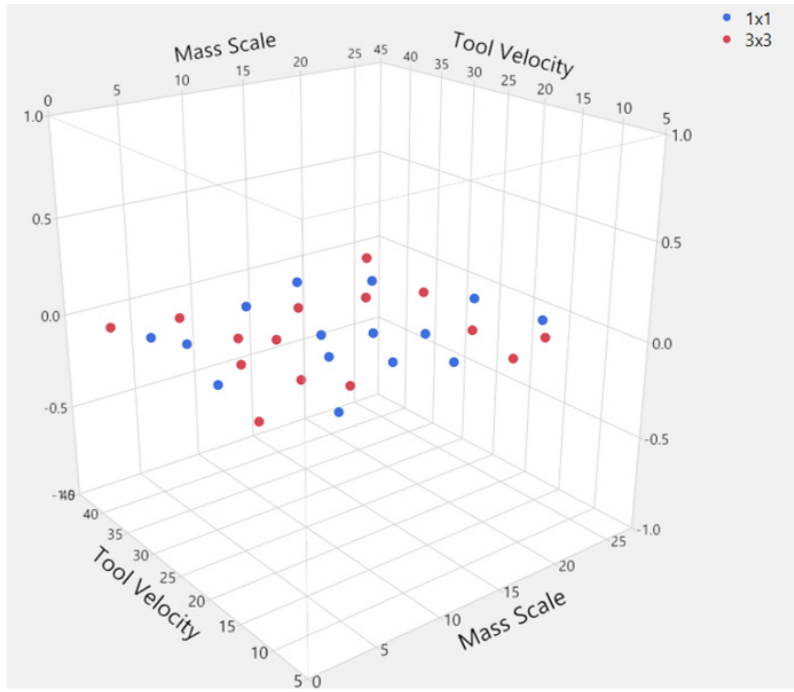
Figure 10. Design points generated by the JMP Fast and Flexible Filling Design. To obtain the final model of neural network training, the five models derived for the optimal value of the tuning parameter were fit to the entire data set. The model that had the highest validation log-likelihood was selected as the final model, and the results reported pertain to that model. The relevant measures obtained during training and validation for the three output variables are shown in Tables